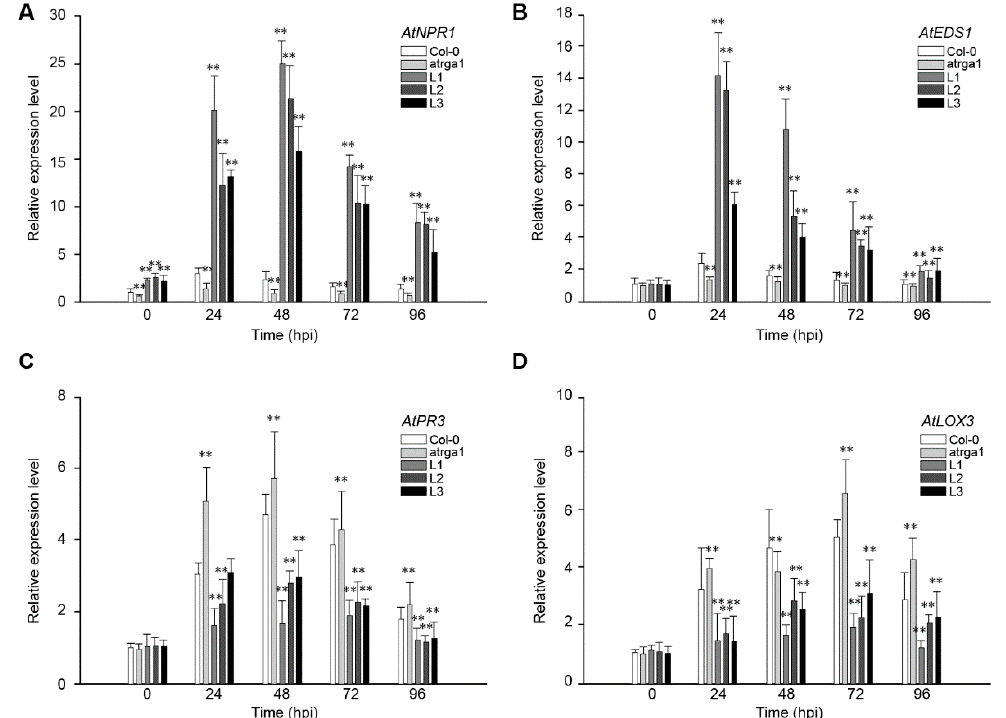
Figure 6. Assessment of the expression of defense-related genes at different time points after inoculating PstDC3000. Relative expression levels of ( A ) AtNPR1; ( B ) AtEDS1; ( C ) AtPR3 , and ( D ) LOX3 were detected via qRT-PCR . Data represent mean values ± SD from three independent experiments. Asterisks show the statistically significant difference (** p < 0.01, Student’s t test).